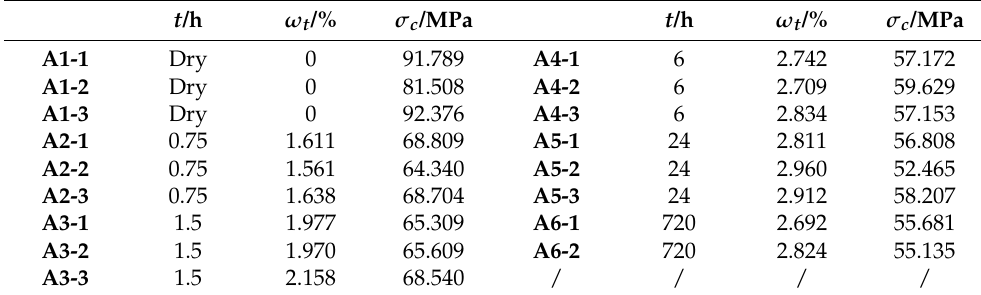
Figure 5. The triaxial compression test results of sandrock containing water. ( a ) Dry Sample; ( b ) Sample Submerged for 0.75 h; ( c ) Sample Submerged for 1.5 h; ( d ) Sample Submerged for 6 h ; ( e ) Sample Submerged for 24 h; ( f ) Sample Submerged for 720 h. Table 2. The rock mechanical parameters in triaxial compression tests. Table 1. Statistics of rock mechanical parameters in uniaxial compression